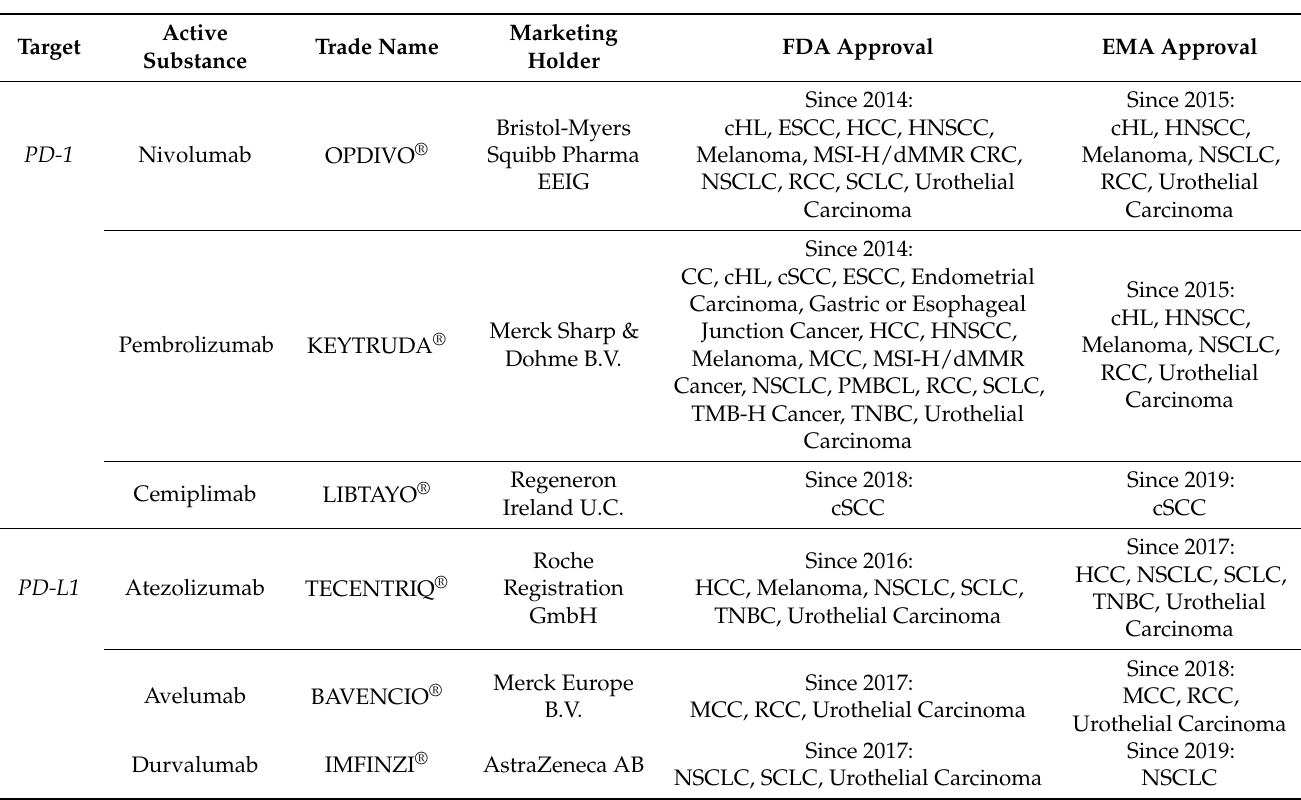
Table 1. Current FDA/EMA approved PD-1 axis blockers.